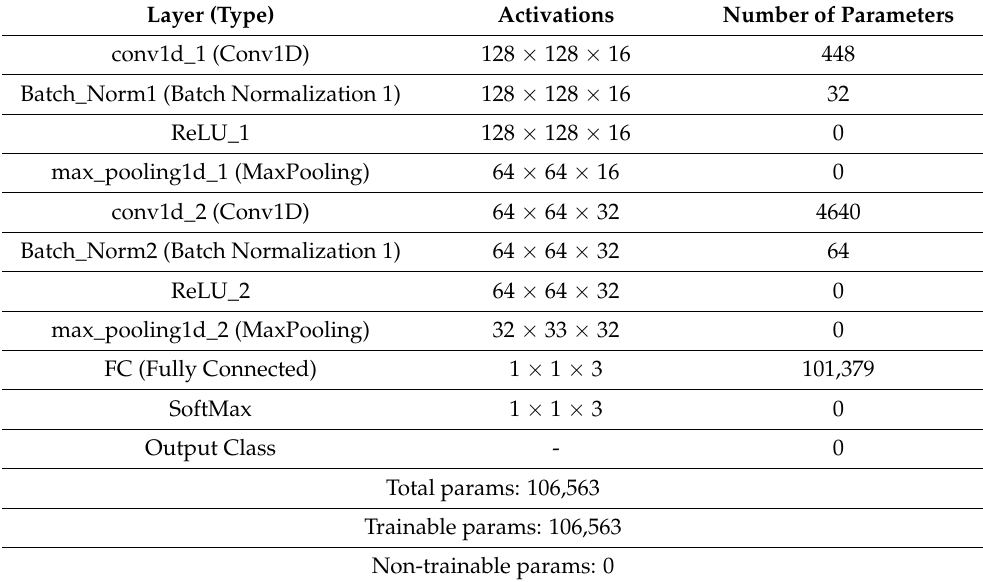
Table 1. Layer-wise details of the deep